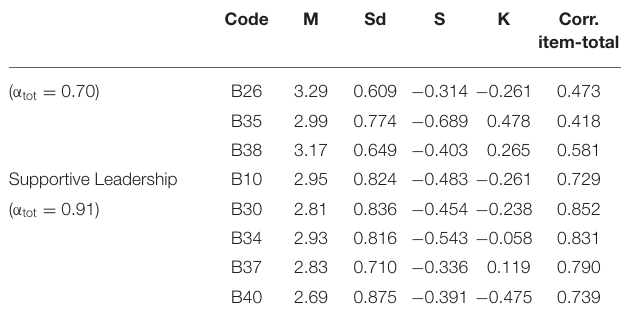
TABLE 1 | Items distribution: descriptive, and reliability analysis by subdimension. Code M Sd S K Corr. Morale ( α tot =